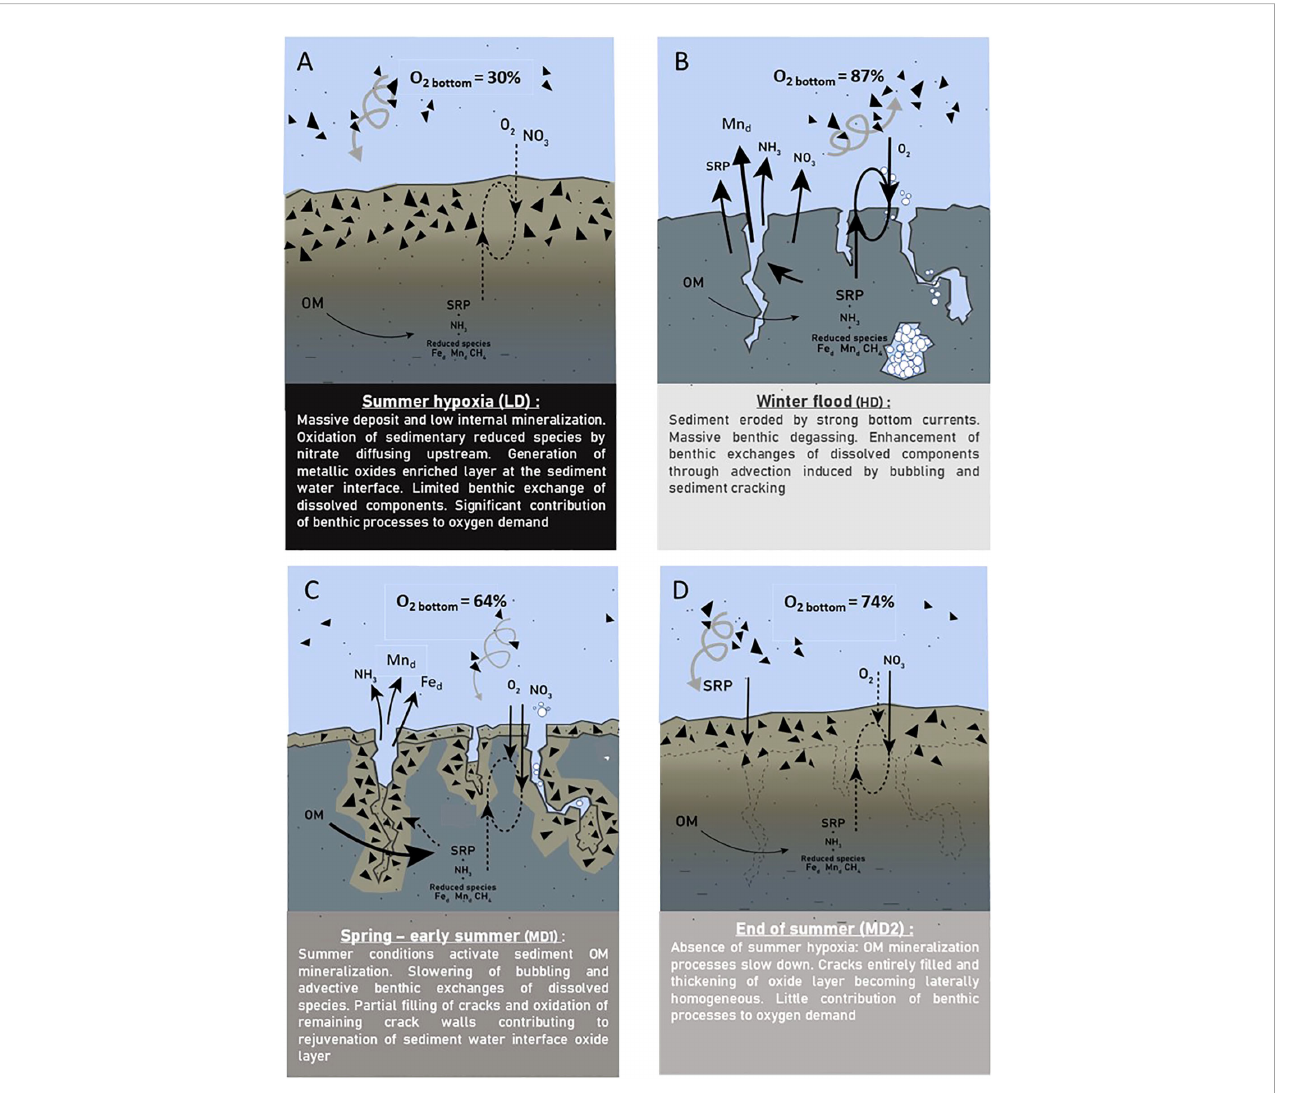
FIGURE 8 Conceptual functioning of benthic processes at Le Pellerin for 2020 – 2021 in the context of hydrological contrasted conditions. (A) August 2020. (B) February 2021. (C) June 2021. (D) August 2021. Dark triangles indicate metallic oxides and hydroxides. Black arrows indicate dissolved exchanges. Brown spirals specify SPM